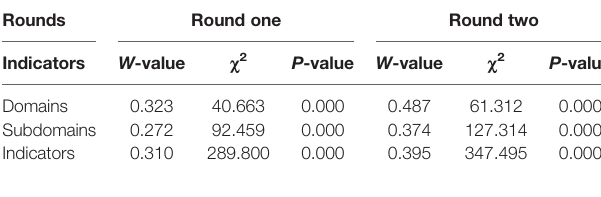
TABLE 3 | Result of expert opinion coordination degree.